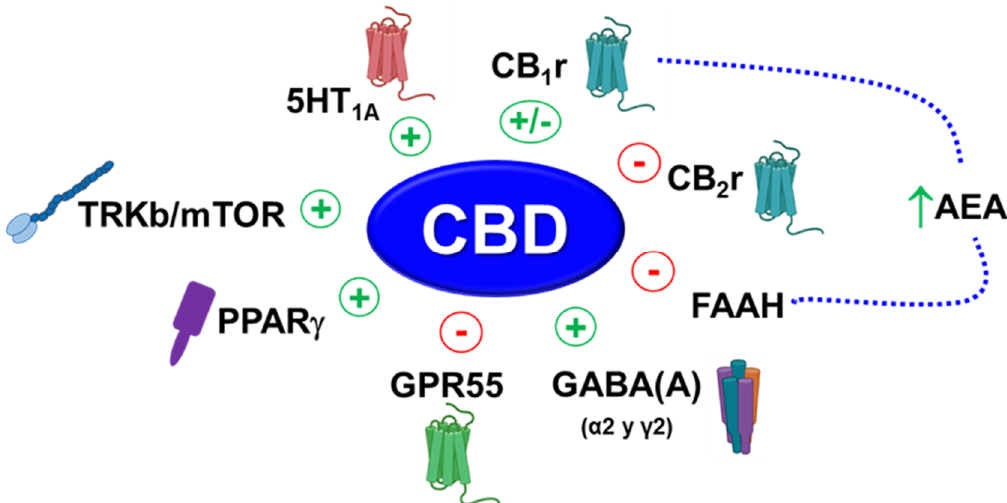
Figure 9. Main targets involved in the anxiolytic and antidepressant actions of CBD. A summary of previously published data and those supported by the present work. 5-HT1A: serotonin 1A receptor; CB1r: cannabinoid 1 receptor; CB2r: cannabinoid 2 receptor; AEA: anandamide; FAAH: fatty acid amide hydrolase; GPR55: G-protein-coupled receptor 55; PPAR γ : Peroxisome proliferator-activated receptor gamma; TRKb/mTOR: Tropomyosin receptor kinase B/mammalian target of rapamycin.